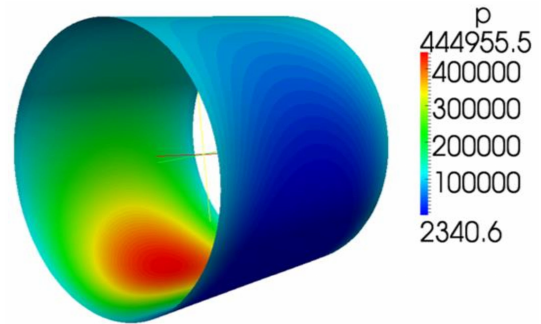
Figure 4. Computational fluid dynamics (CFD) results: Pressure contour